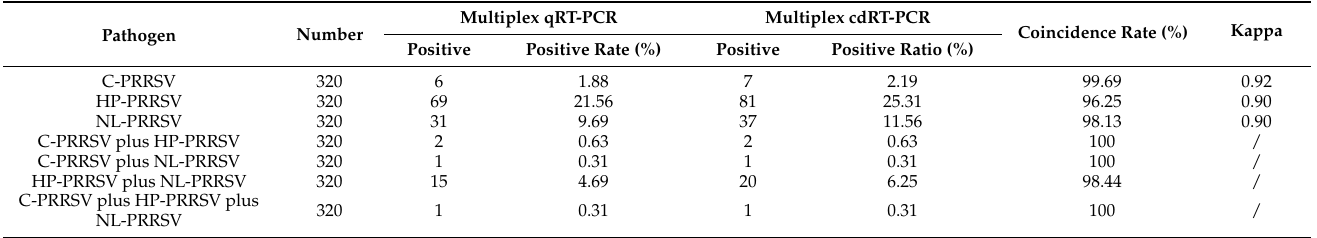
Table 4. Detection results of the clinical samples by the multiplex cdRT-PCR and the multiplex